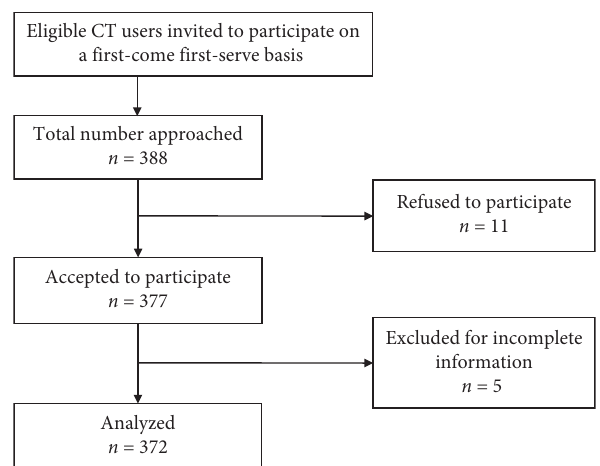
Figure 1: Participant selection flowchart.